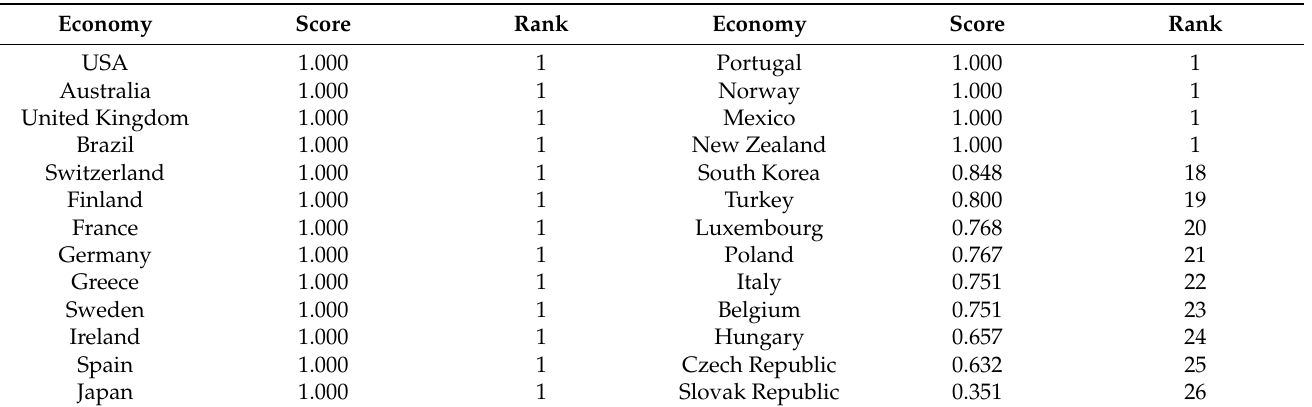
Table A1. Rankings and scores of energy resilience.